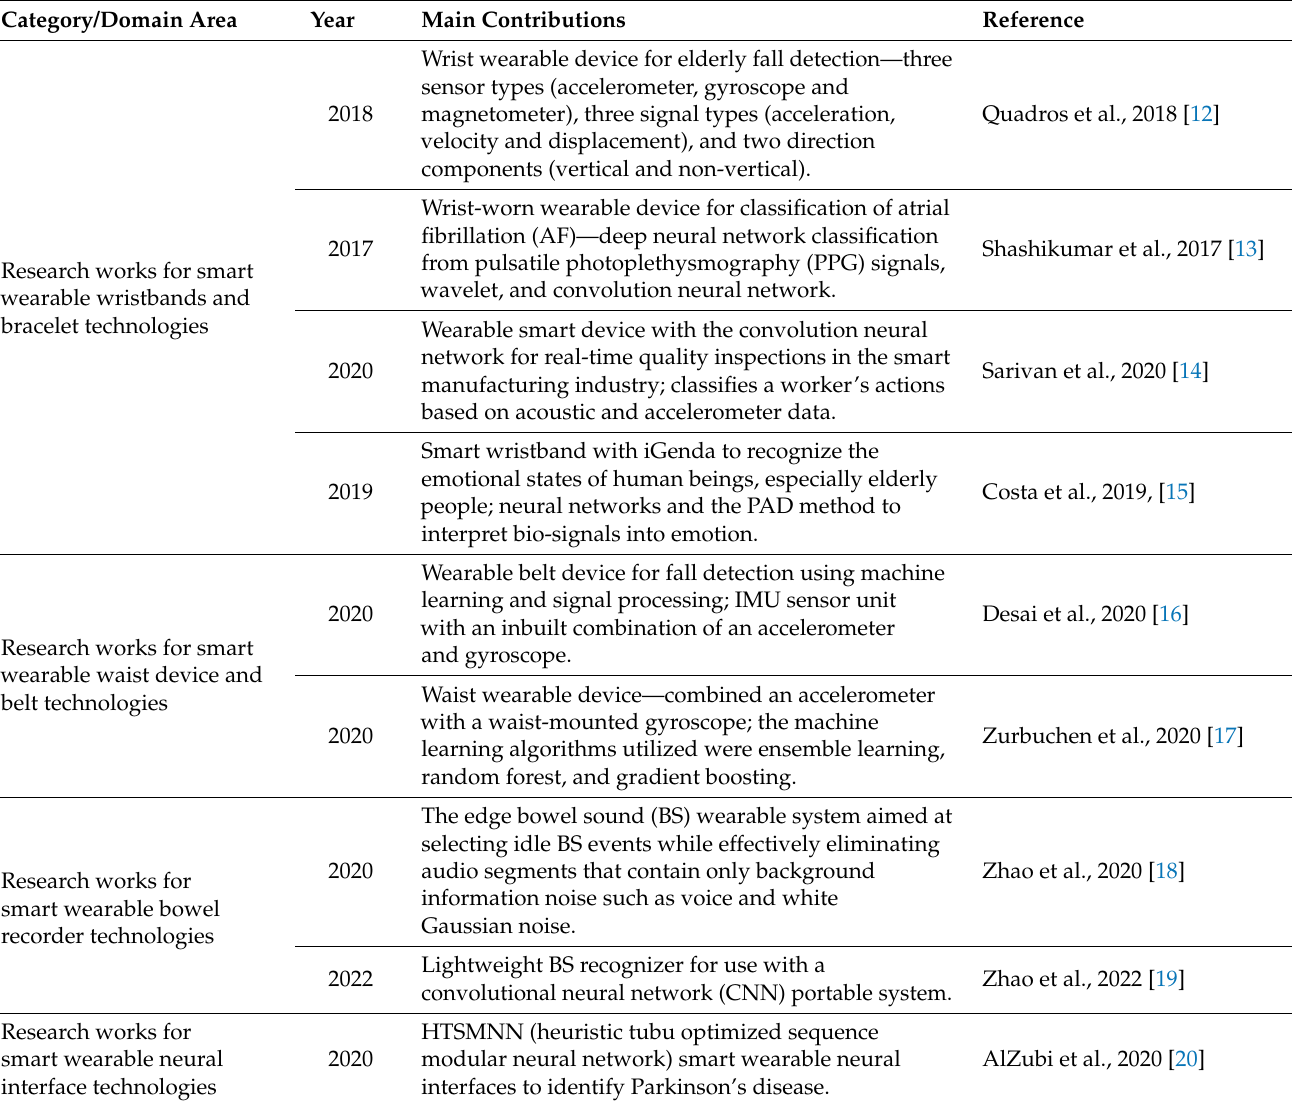
Table 2. Some representative works on wearable and smart device